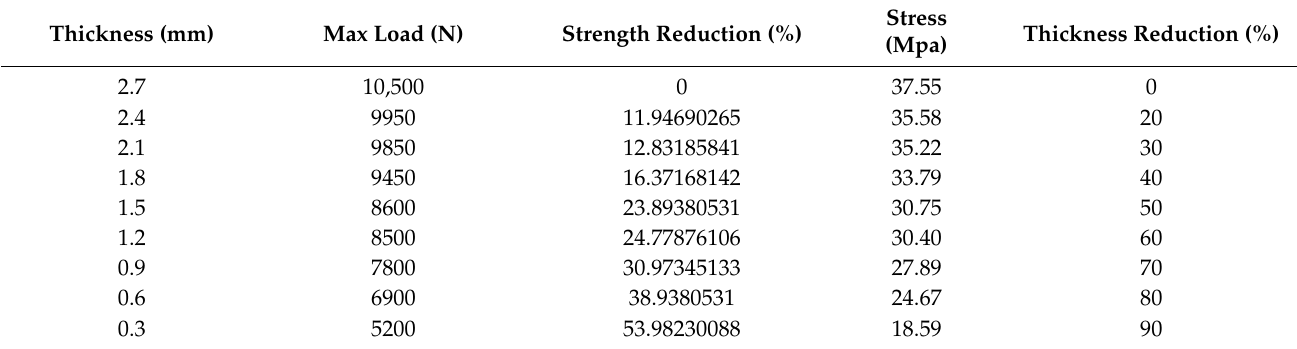
Figure 18. Strength reduction vs. Thickness reduction for upper longeron Table 3. Details of analysis based on the remaining